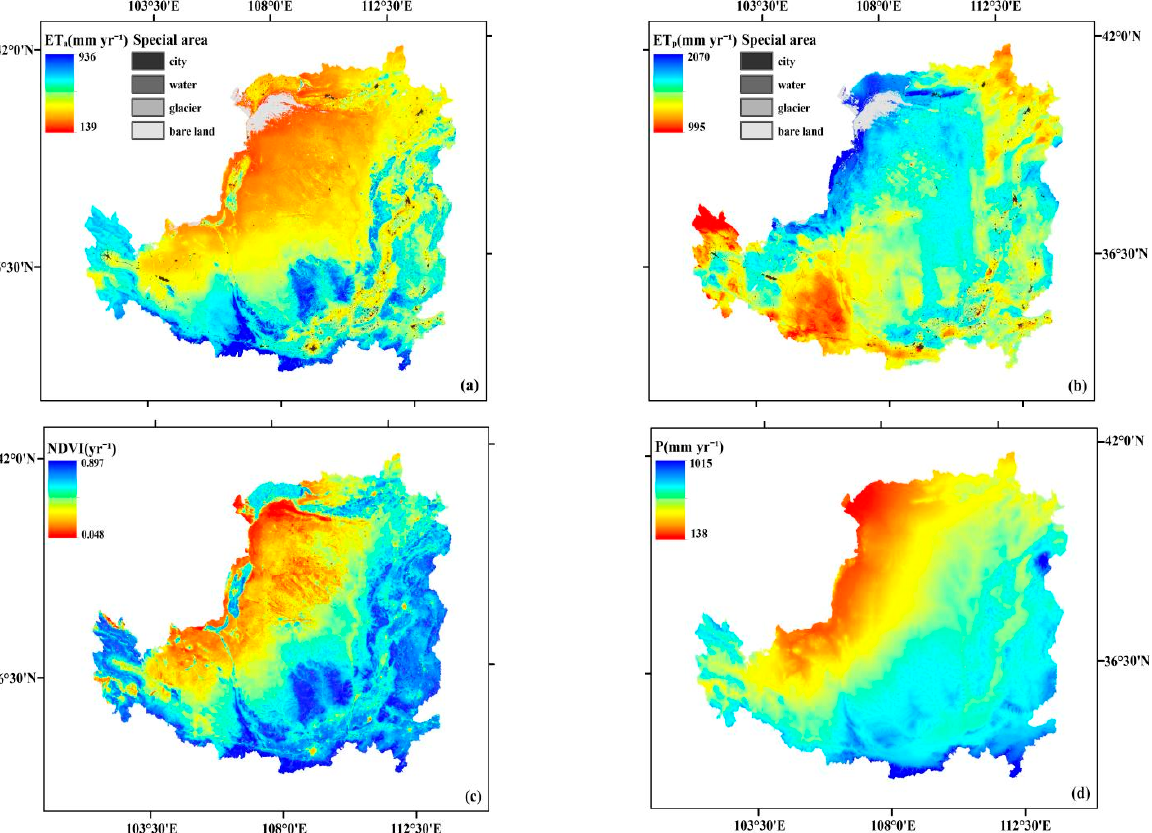
Figure 3. Spatial patterns of mean annual actual evapotranspiration ET (ET a ) ( a ), potential ET (ET p ) ( b ), normalized difference vegetation index (NDVI) ( c ), precipitation (P) ( d ) from 2000 to 2018 in the Loess Plateau (LP).